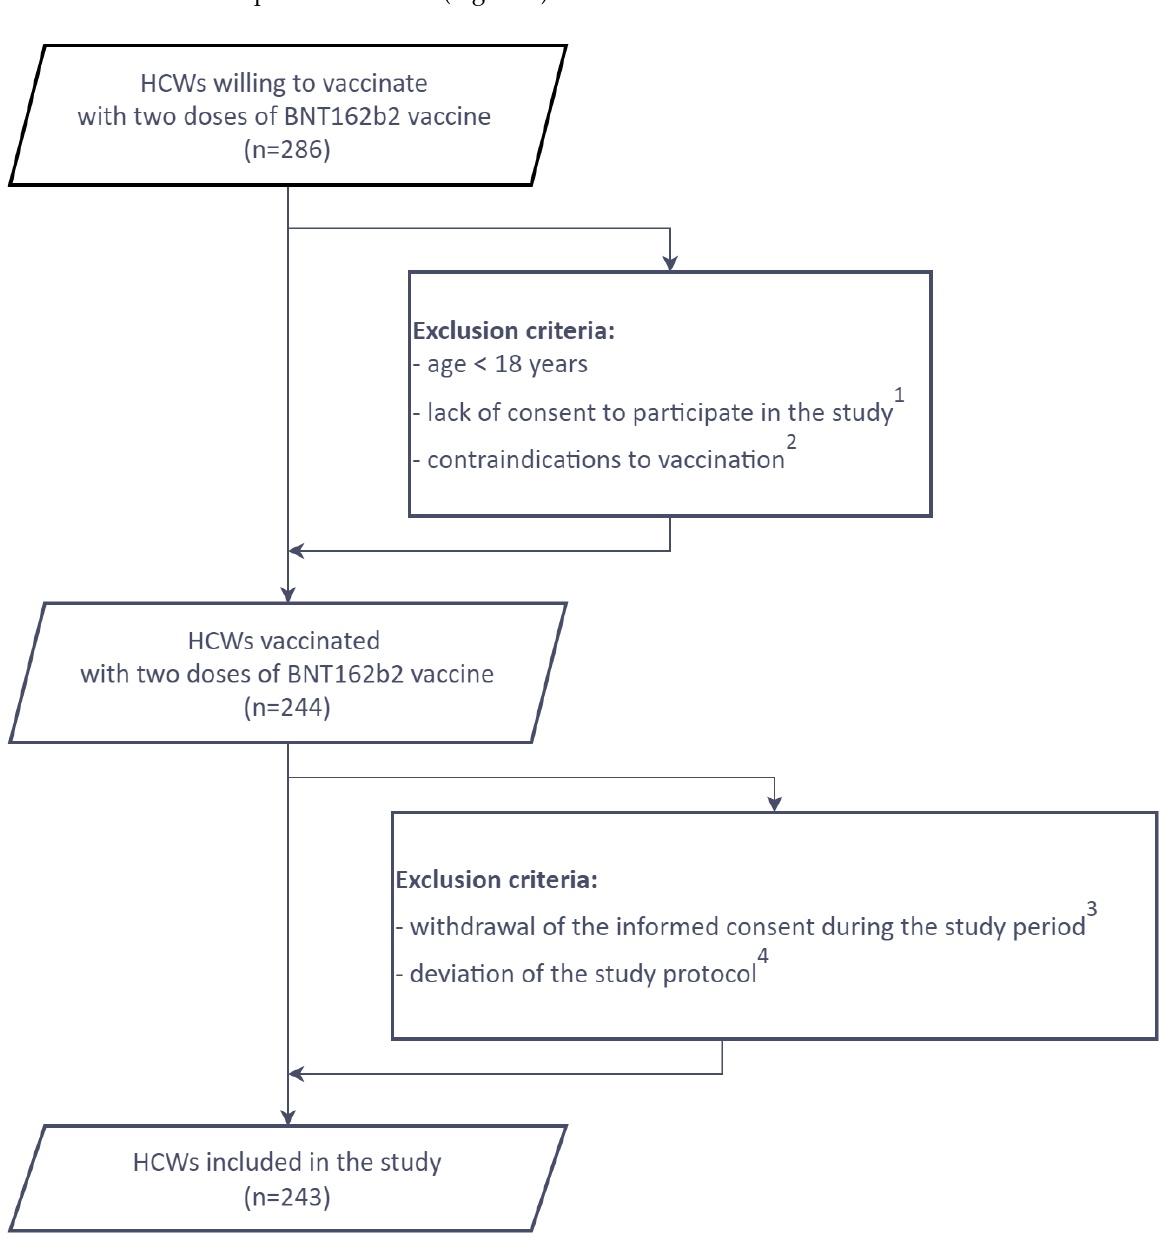
Figure 1. Flowchart of study selection based on the inclusion and exclusion criteria. Legend: 1—lack of one’s consent to participate in the study after becoming acquainted with the study informed consent form and planned four blood collection schedule (Figure 2); 2—medical contraindications to vaccination; 3—withdrawal of the informed consent during the study period for personal or other reasons; 4—deviation of the study protocol (i.a., not being able to participate at the blood collection according to predicted blood collection schedule). Abbreviations: HCWs—healthcare workers.